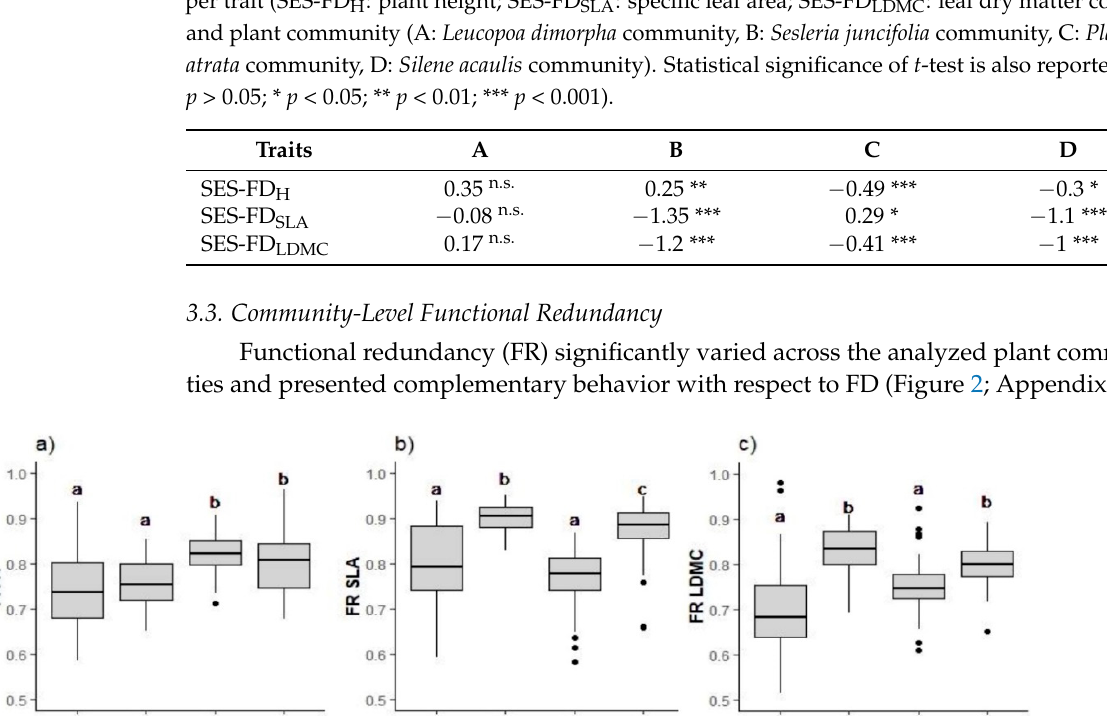
Table 3. Results of the two-tailed t-test assessing the standardized effect size of functional diversity